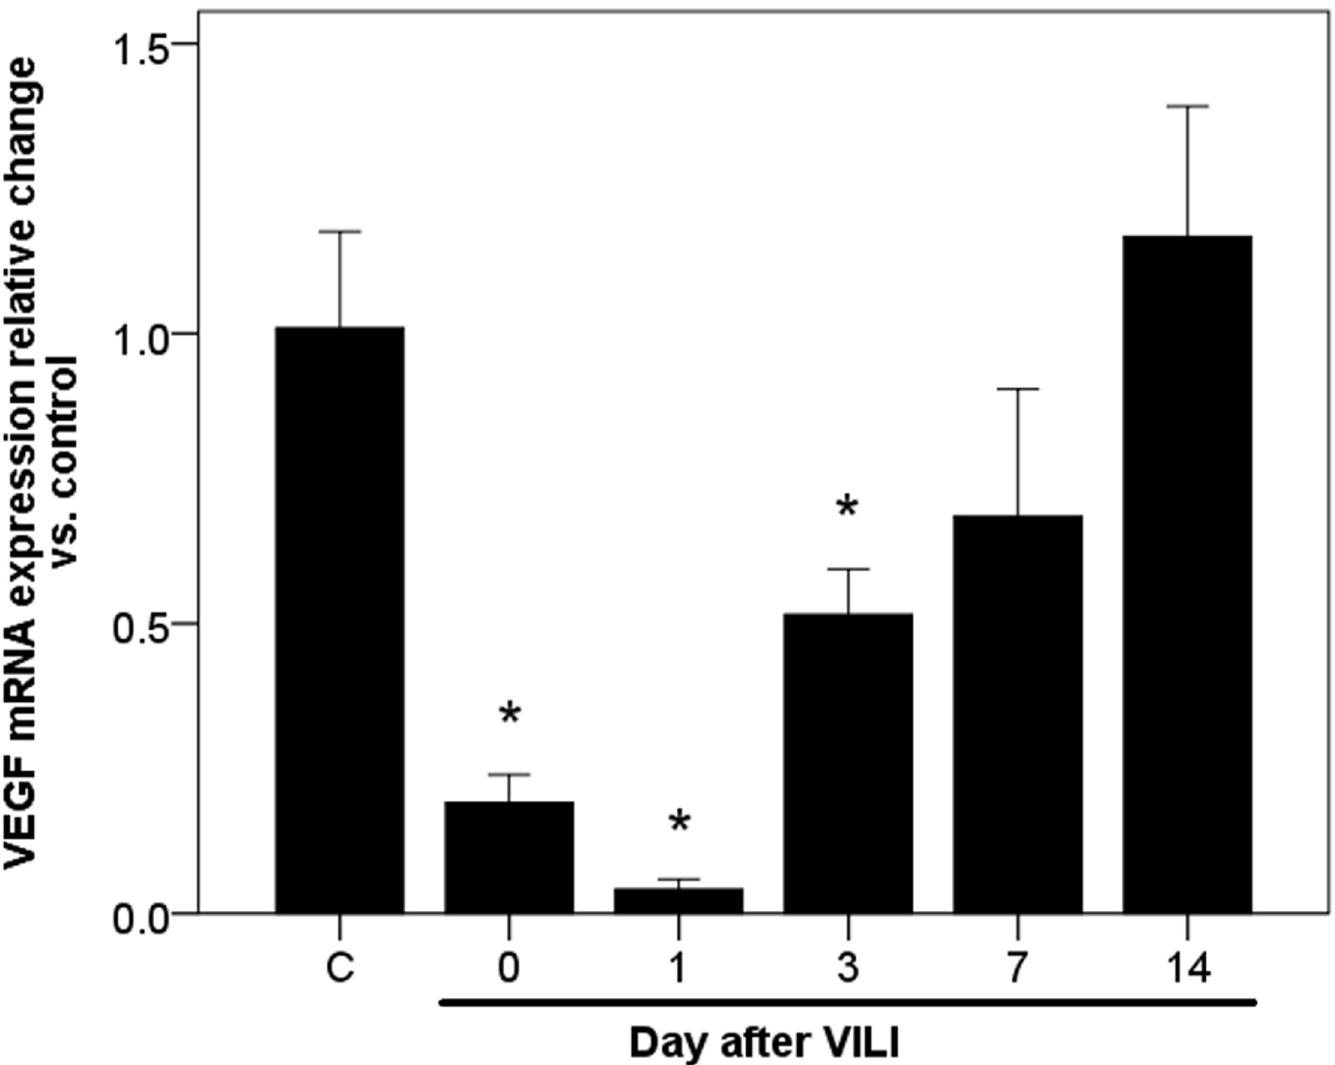
Fig 5. Time course of VEGF mRNA expression in lung-recruited monocytes following VILI. mRNA expression was presented as the relative change versus untreated control. Statistical analysis was performed using ANOVA. Data are expressed as means ± SD; n = 4–5 per group, � p < 0.05, vs. normal control